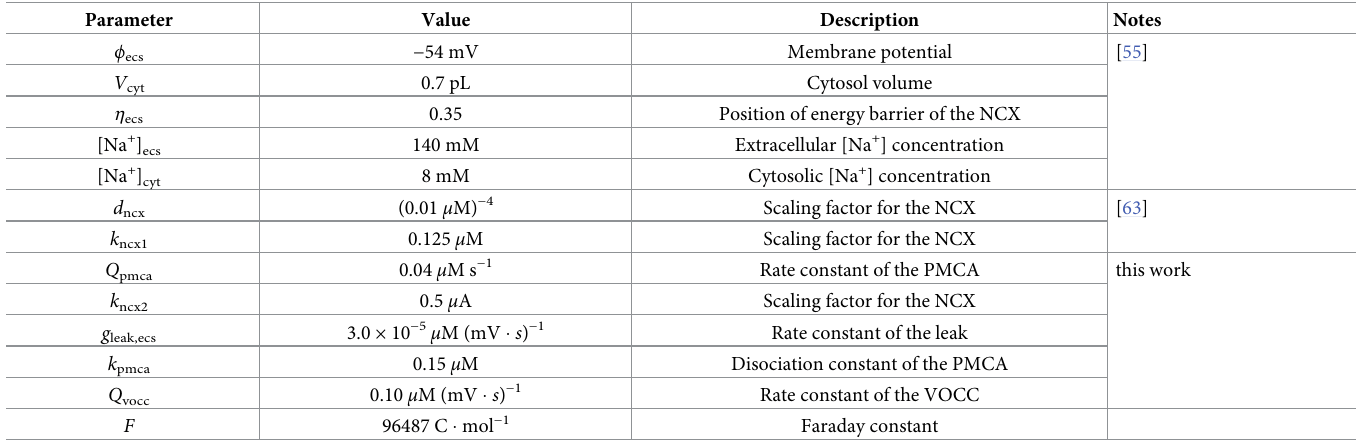
Table 4. Plasma-membrane and extracellular specific model parameters. Parameter